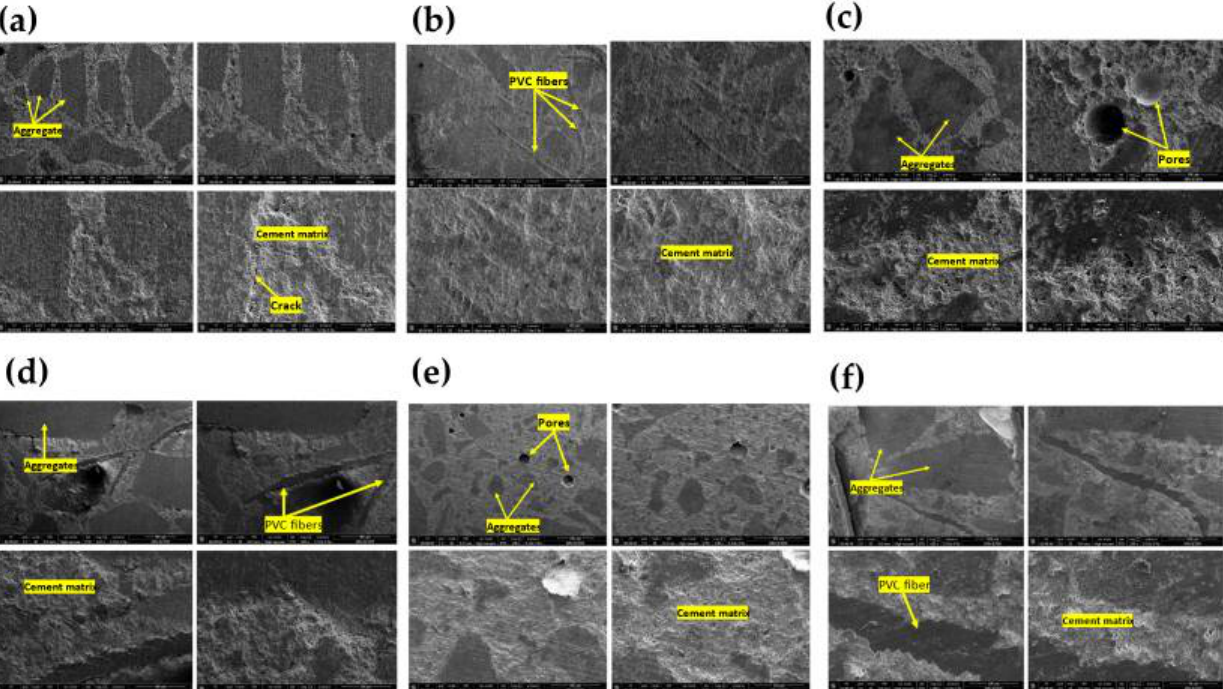
Figure 27. SEM micrographs of ( a ) CS0 sample, ( b ) CS3 sample, ( c ) MS15 sample, ( d ) MS15P3 sample, ( e ) SF15 sample, ( f ) SF15P3